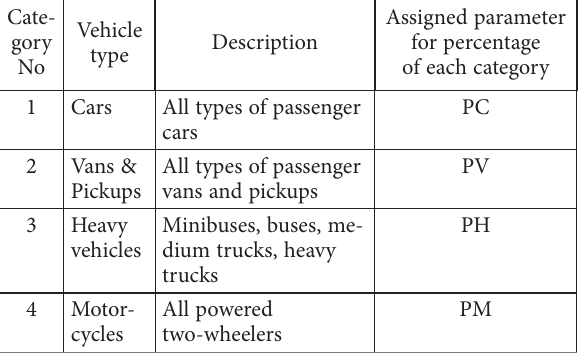
Figure 5. Measuring the average speed from videos Table 2. Types of heavy vehicles involved in the